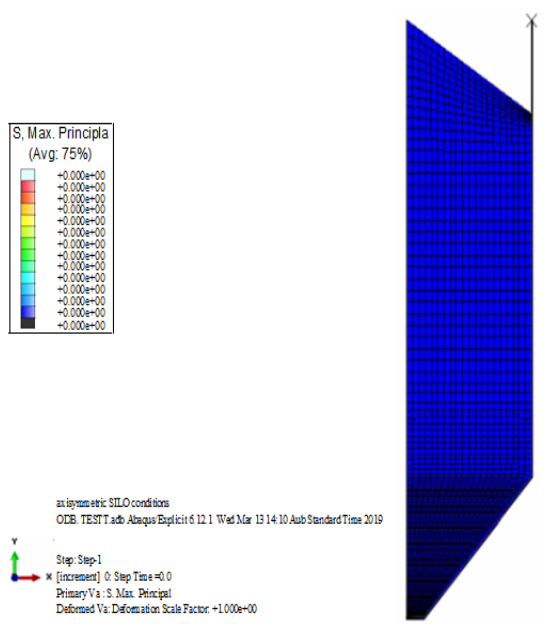
Figure 16 : Silo model without insert (Abaqus).